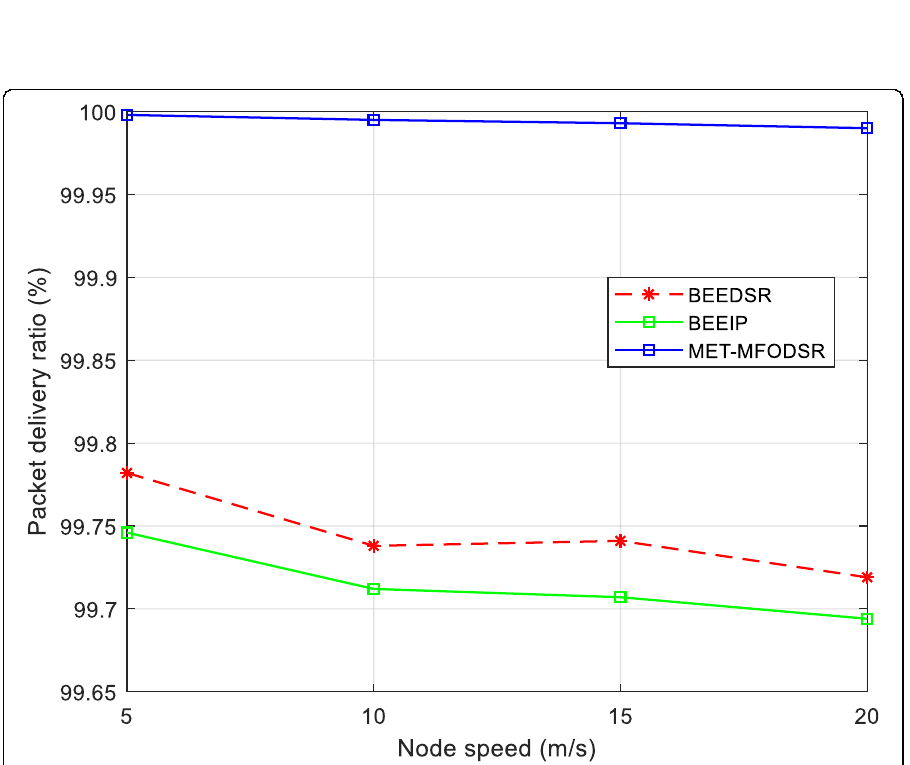
Fig. 11 Packet delivery ratio simulation results for BEEDSR, BeeIP, and MET-MFODSR. The simulation results of the packet delivery ratio under the node speed variation